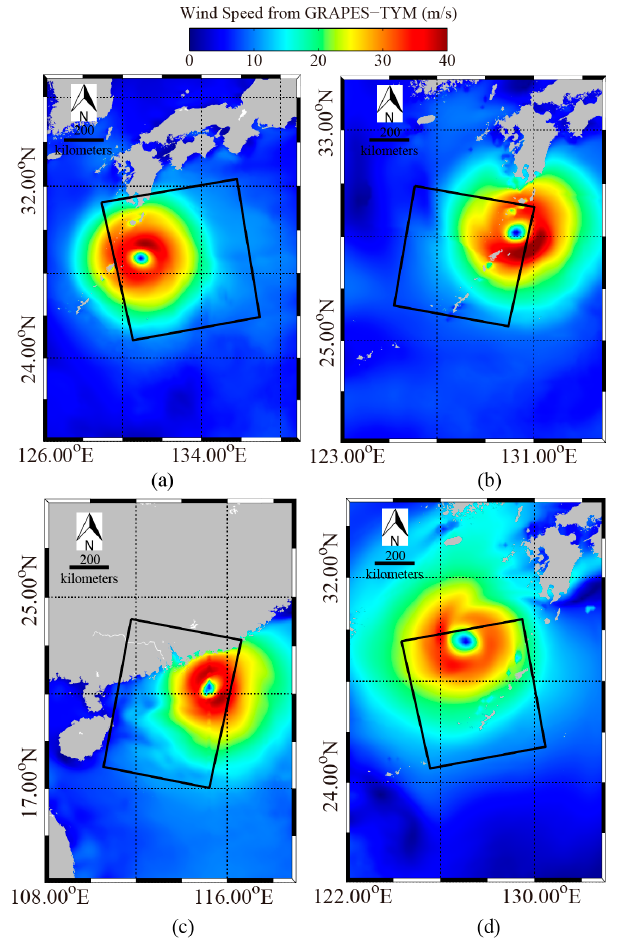
Figure 10. GRAPES-TYM wind maps, in which the rectangles represent the coverage of the corresponding three VH-polarization GF-3 SAR images in Figure 3. ( a ) GRAPES-TYM wind maps of typhoon e on 4 August 2017 at 09:00 UTC. ( b ) GRAPES-TYM wind maps of typhoon Noru on 4 August 2017 at 21:00 UTC. ( c ) GRAPES-TYM wind maps of typhoon Hato on 22 August 2017 at 22:00 UTC. ( d ) GRAPES-TYM wind maps of typhoon Talim on 16 September 2017 at 09:00 UTC. The comparison between SAR-derived winds and GRAPES-TYM winds is shown in Figure 11.